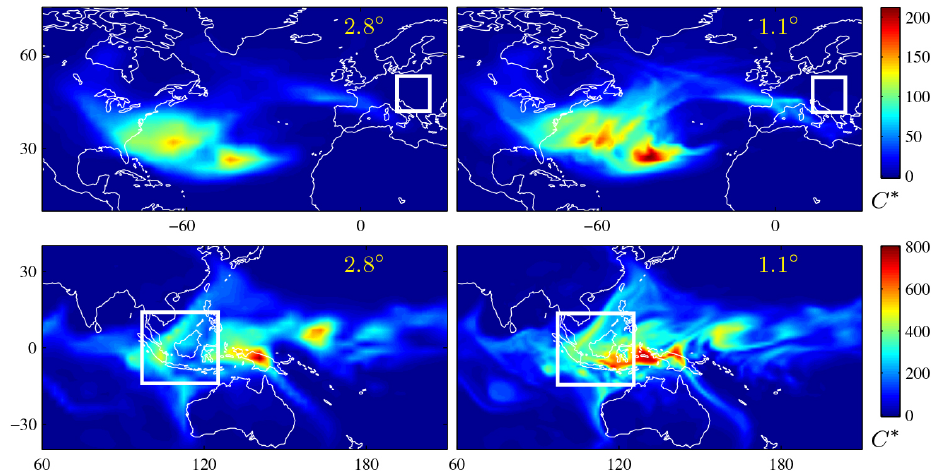
Figure 5. Comparison of the sensitivity maps C ∗ (λ,φ) for test cases I (top) and II (bottom) obtained from RETRO-TOM run at a resolution of 2 . 8 ◦ × 2 . 8 ◦ (left) and 1 . 1 ◦ × 1 . 1 ◦